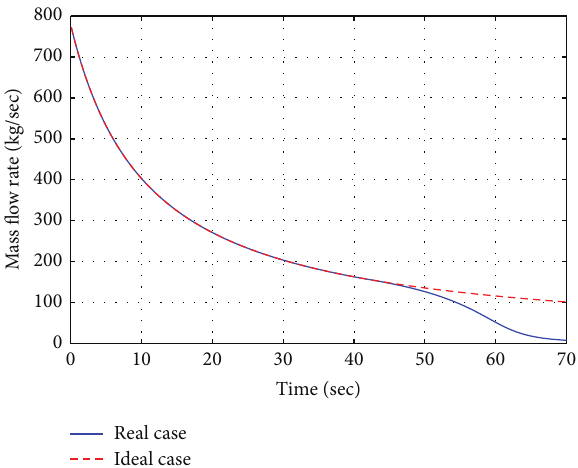
Figure 2: Coastdown of the pump with time (HANARO).